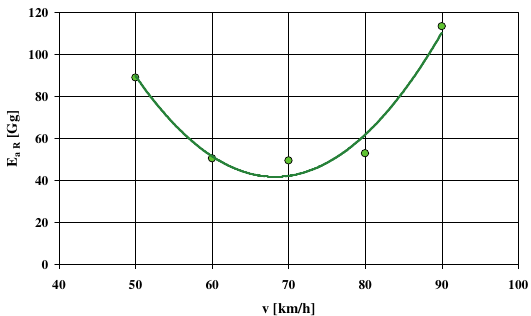
Fig. 2. Dependence of the national annual emission of carbon monoxide from passenger cars upon the average velocity, under model conditions of rural traffic